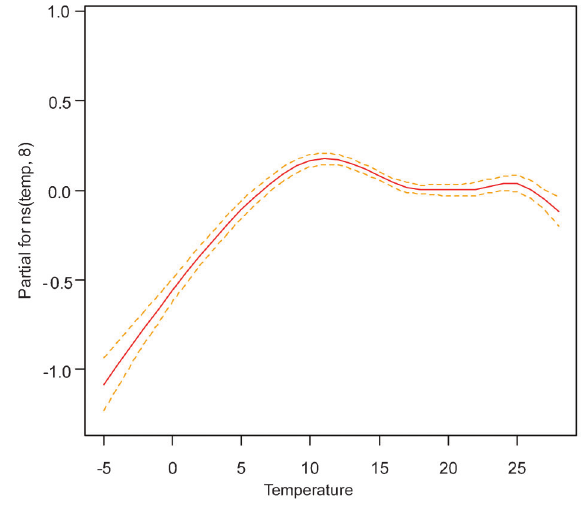
Figure 2. Air temperature effect graph (8 degrees of freedom).